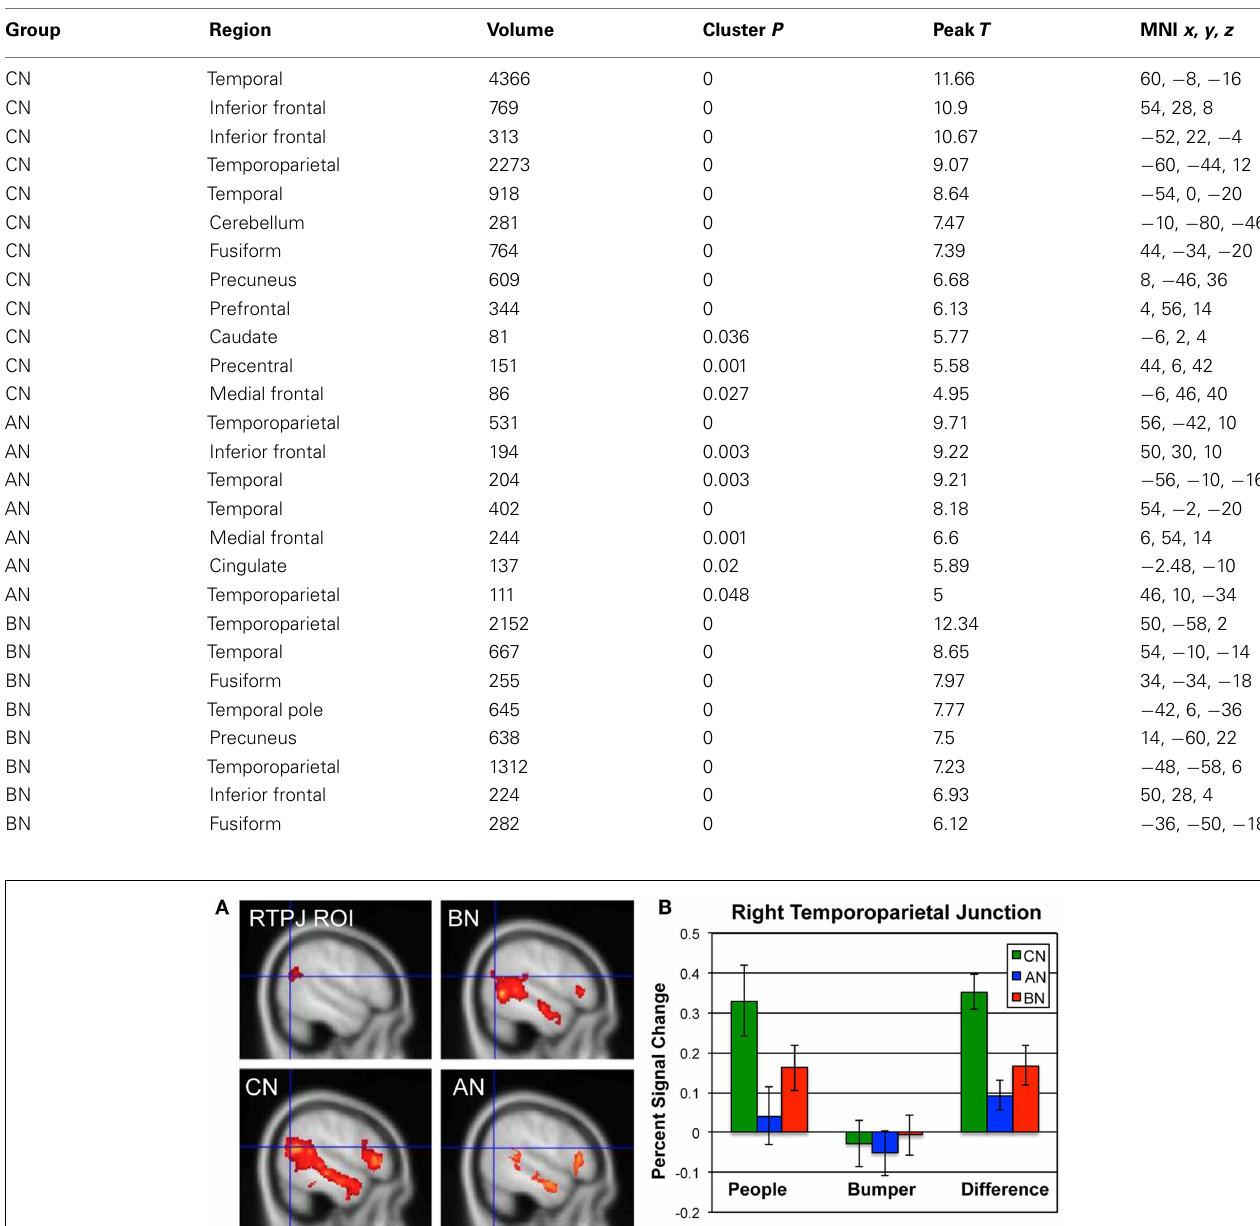
Table 2 | Clusters in the CN,AN, and BN group maps during the People–Bumper contrast of the social attribution task.